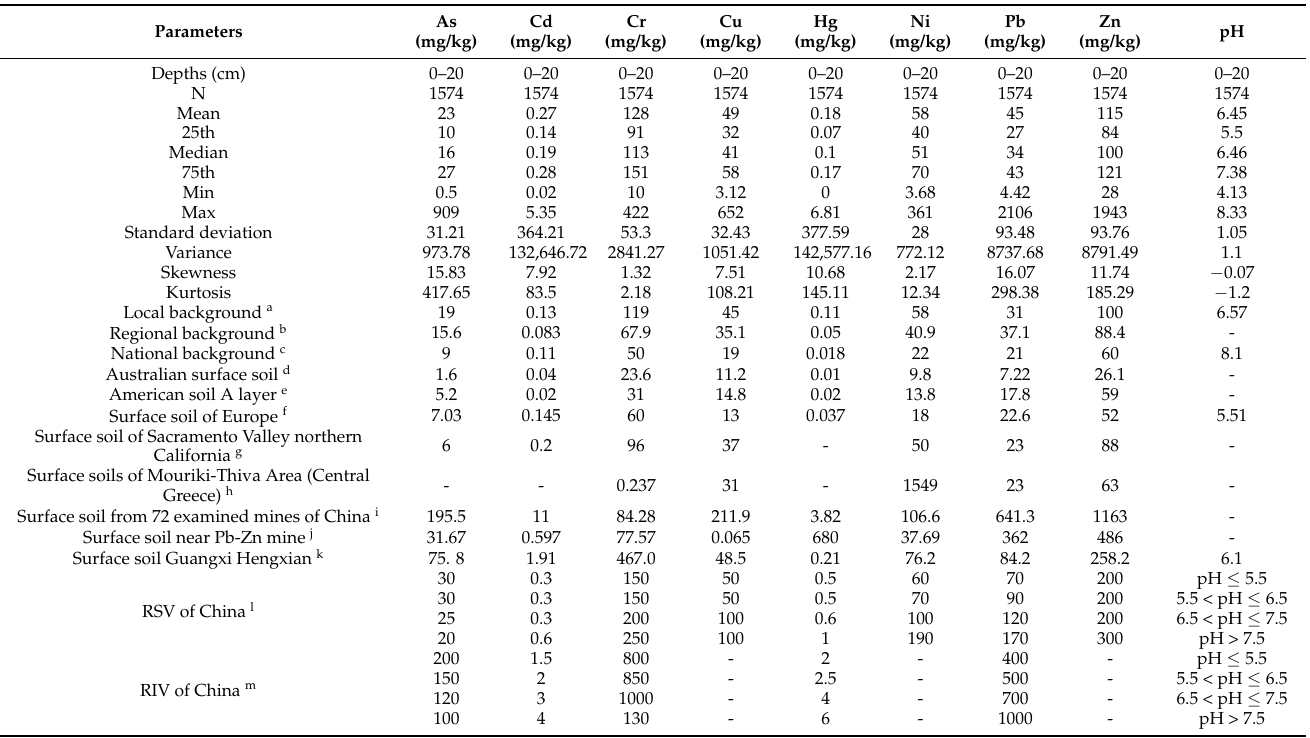
Table 3. Descriptive statistics of PTEs in the surface soil of the study area and the local, regional, and national background values and related